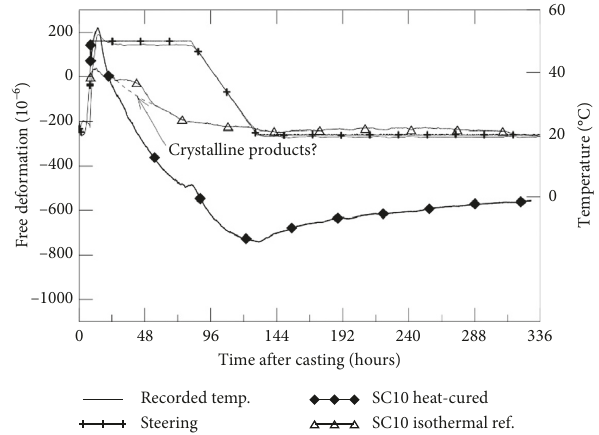
Figure 5: Free deformations and temperature development recorded on SC10